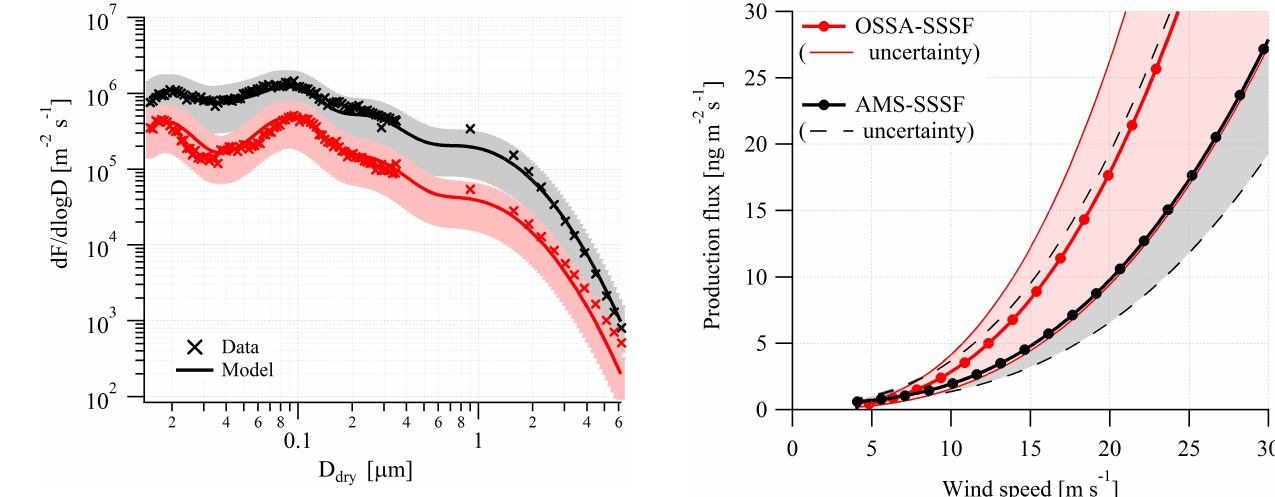
, red at 5.2 × 10 5 w Fig. 6. Comparison between the SSA mass flux calculated using the OSSA-SSSF (see text) (Red lines) with the HR-ToF-AMS derived mass flux (Ovadnevaite et al., 2012) (Black lines) as function of wind speed. Pink and grey areas represent the associated measure- ment